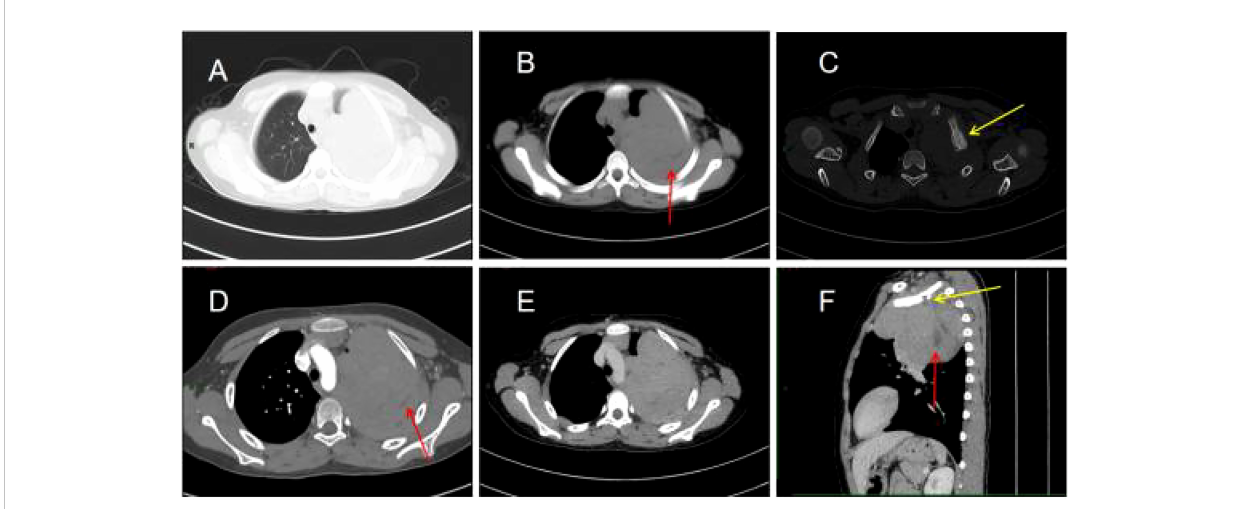
FIGURE 1 Chest computed tomography (CT) images (A – F) . (A) Irregular soft tissue density mass in the upper left thorax. (B) The mediastinal window shows a lamellar hypodense shadow within the mass (arrow). (C) The bone window shows bone destruction of the left fi rst rib and visible periosteal new bone formation (arrow). (D) Mild to moderate heterogeneous enhancement of the lesion with non-enhancing hypodense areas within it (arrow). (E) Persistent enhancement of the lesion in the venous phase. (F) The sagittal section shows bone destruction of the left fi rst rib (yellow arrow) and lamellar hypodense areas within the mass (red